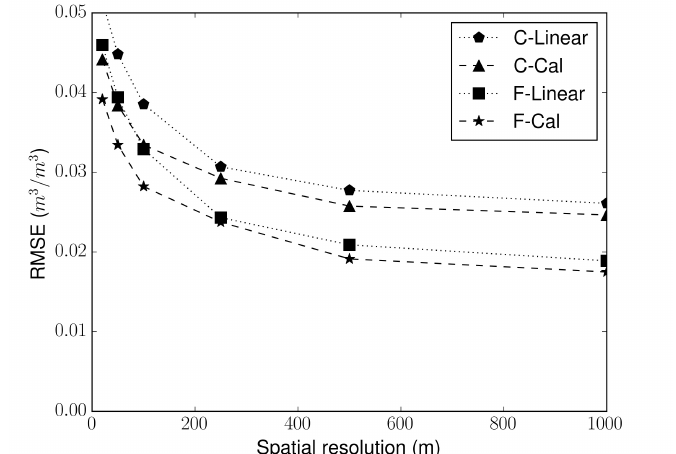
Figure 13. Behaviour of the observed mean RMSE for all the four experiments of MAPSM with the spatial